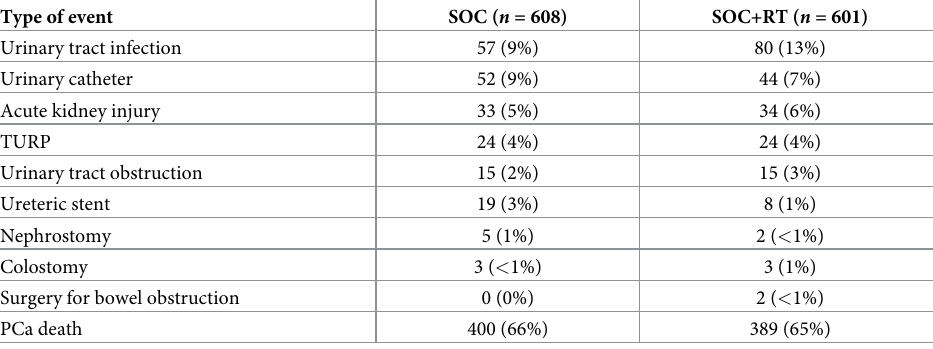
Surgery for bowel obstruction 0 (0%) 2 ( < 1%) PCa death 400 (66%) 389 (65%) PCa, prostate cancer; RT, radiotherapy to the prostate; SOC, standard of care; TURP, transurethral resection of the prostate.